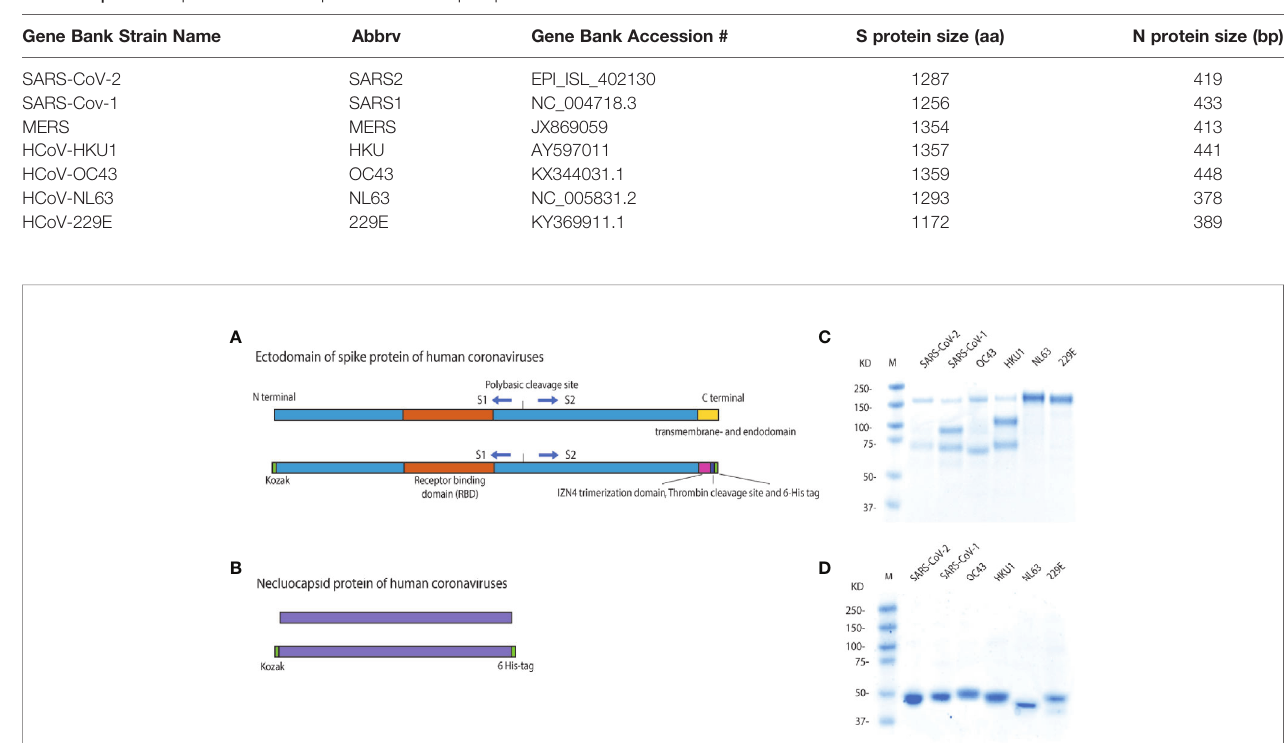
FIGURE 2 | Constructs for recombinant spike and nucleocapsid protein expression. (A) Schematic of the wild type HCoV full length spike protein (S), with the ectodomain, receptor binding domain, furin cleavage site, S1, S2, and transmembrane and endodomain domains indicated; and the soluble trimeric spike. In the protein constructs, the transmembrane and endodomain were replaced with a region containing an IZN4 trimerization domain, a thrombin cleave site and a 6X-hexahistidine tag. (B) Schematic of the construct of nucleocapsid (N) proteins of human coronavirus strains. (C) Reducing SDS-PAGE gel of the expressed and puri fi ed, soluble, and trimerized HCoV spike proteins. These proteins have a furin-like cleavage site, similar to the related b HCoVs (26 – 28). While the proteins have multiple bands under reducing conditions, both bands were pulled down with Ni-NTA His-tag af fi nity beads, indicating that both cleaved subunits are still bound together in native conditions, but disassociate in the denaturing conditions. (D) The reducing SDS-PAGE gel of the expressed and puri fi ed HCoV nucleocapsid proteins.